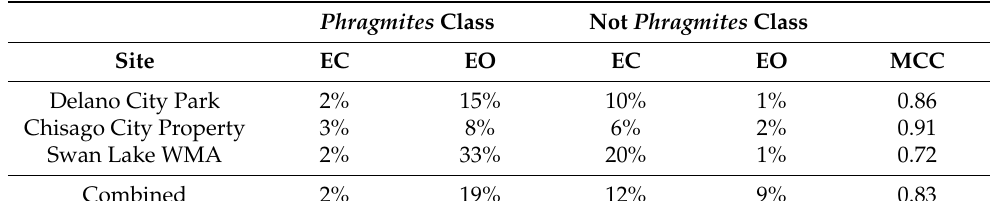
Table 21. Errors of commission (EC), errors of omission (EO), and Matthews correlation coefficient (MCC) values for the support vector machine classification with the post-ML OBIA rule set.